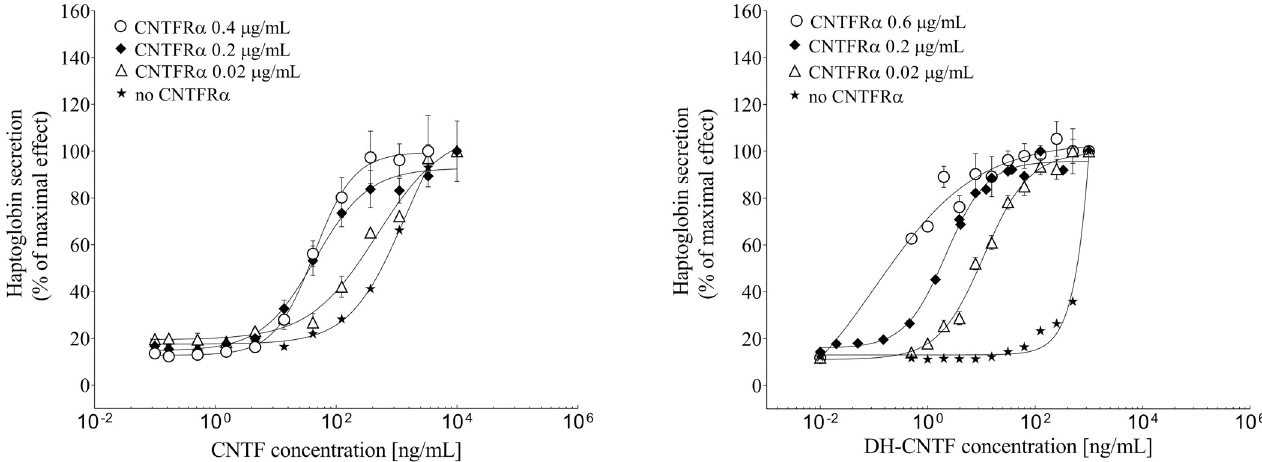
Fig 1. Biological activity of CNTF and DH-CNTF. HepG2 cells were treated with CNTF and DH-CNTF in the absence and presence of different amount of soluble CNTFR α . Results were expressed as a percentage of the maximal CNTF-induced response. Each concentration point was the mean ± S.E. from at least three independent experiments.